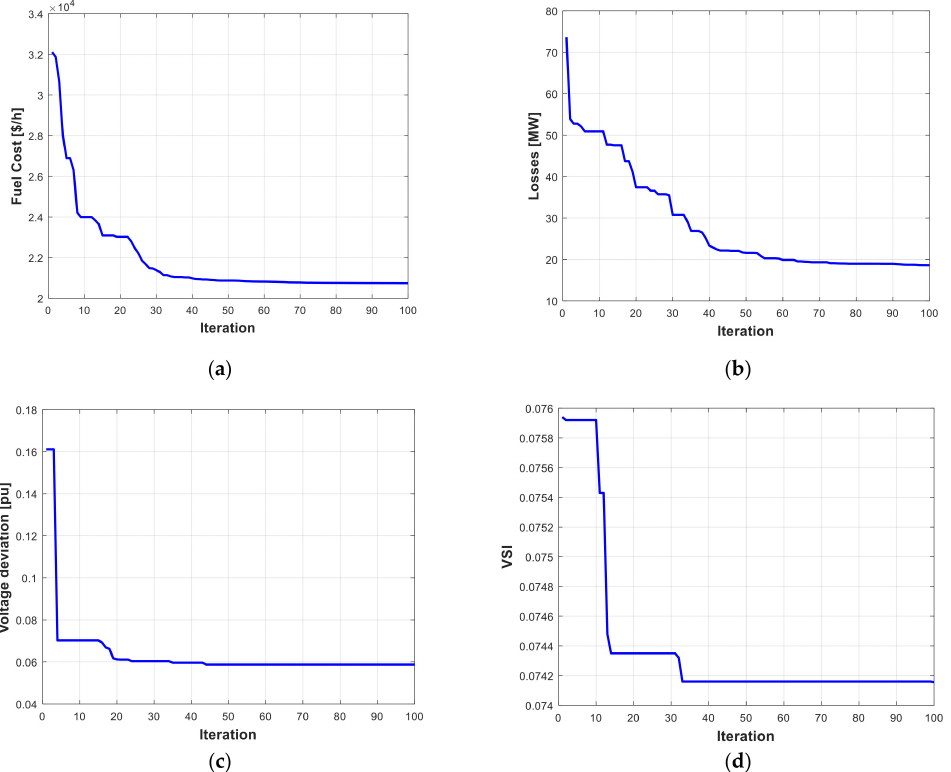
Figure 11. The convergence characteristics of the SMA algorithm for Cases 26–29 on the ISGHV 400 kV network. ( a ) Case 26, ( b ) Case 27, ( c ) Case 28, ( d ) Case